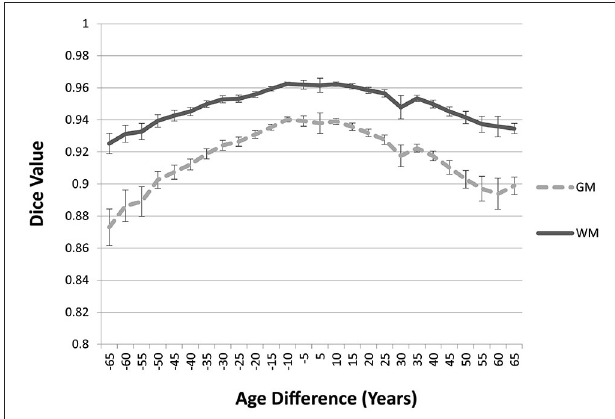
FIGURE 7 | Age-appropriate segmentation priors compared to those from priors of different ages . Partial volume estimates (PVE’s) for both gray matter (GM) and white matter (WM) were derived from segmentation using age appropriate (five-year range) priors, as well as priors derived from younger and older age groups. These PVE’s were compared and averaged across participants and age groups, and mean Dice similarity values are shown by age difference from the participant. Note the consistent drop off in similarity, as utilized priors grow farther from the appropriate age range.